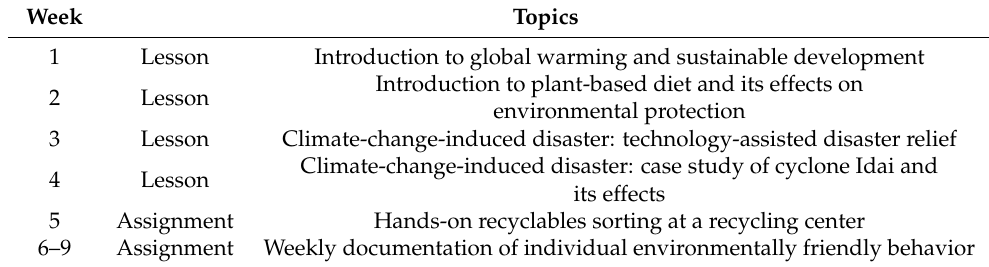
Figure 1. Tzu Chi University Environmental Education Program and its theory of change. Table 1. Tzu Chi University Environmental Education Program.